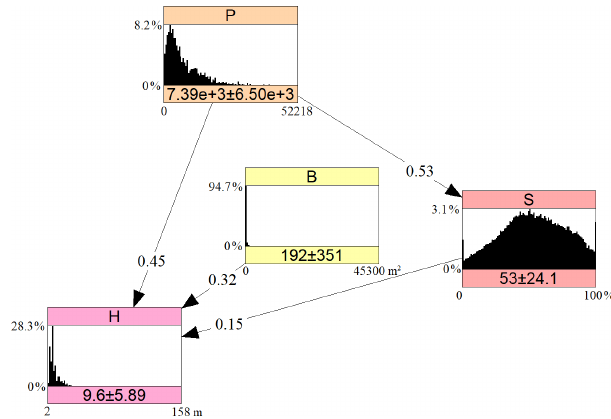
Figure 2. A Bayesian network for predicting residential building height. Values on the arcs represent the (conditional) rank correla- tion; values under the histograms showing the probability density function are the mean and standard deviation of the marginal distri- butions, with density on the y axis and minimum–maximum values on the x axis. H – building height (m); P – population density (per- sonskm − 2 ); S – soil sealing (%); B – building footprint area (m 2 ). Graph generated using Uninet software (Hanea et al.,